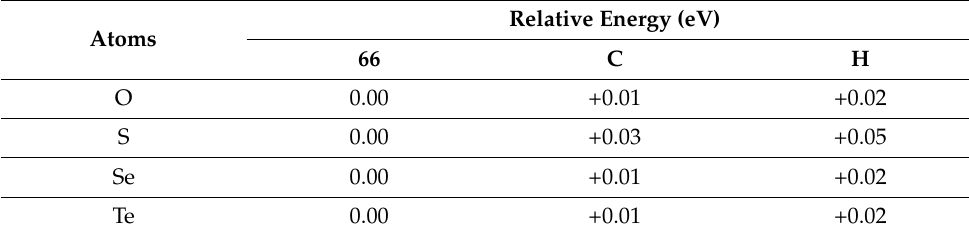
Table 2. Relative energies of three different configurations (66, C and H) of each dopant.